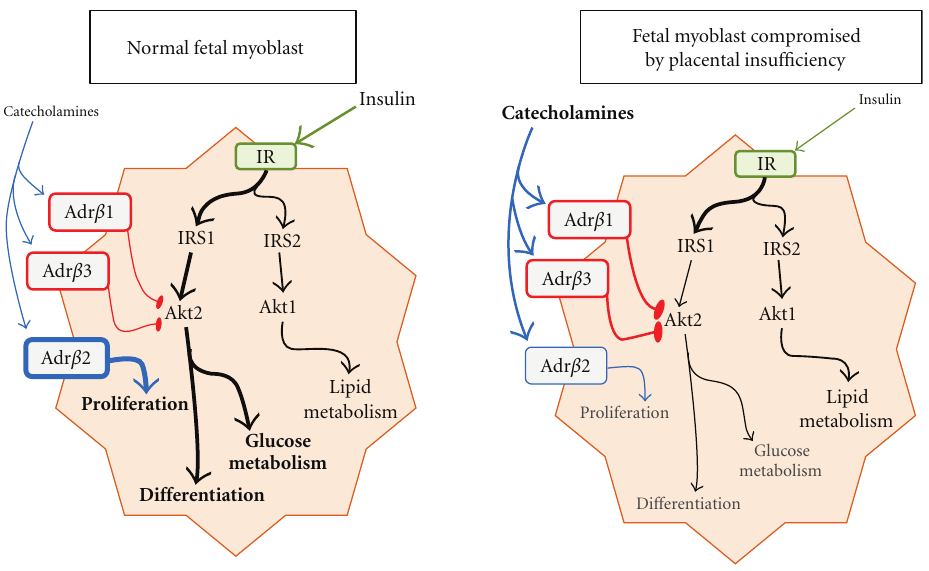
Figure 2: Impact of placental insu ffi ciency on endocrine responsiveness in fetal myoblasts and myofibers. Adrenergic activity increases due to greater circulating catecholamines. Adrenergic receptor β subtype-specific desensitization results in a greater proportion of signaling through Adr β 1 and Adr β 3 because Adr β 2 expression is reduced. Insulin signaling is reduced due to adrenergic suppression of insulin secretion in pancreatic β -cells and by muscle adrenergic signaling that negatively influences the insulin-Akt2 intercellular signaling pathway. These developmental adaptations reduce rates of myoblast proliferation and di ff erentiation as well as glucose metabolism in skeletal